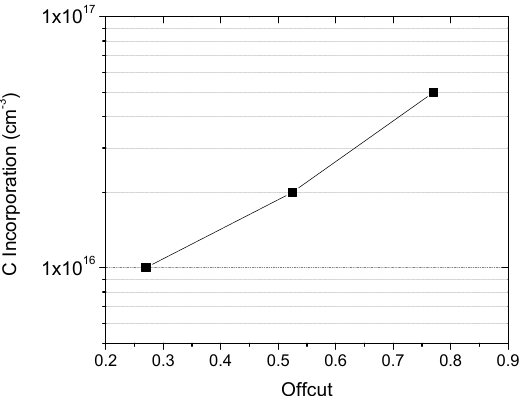
Figure 8. Dependence of C incorporation in homoepitaxial films as a function of offcut.